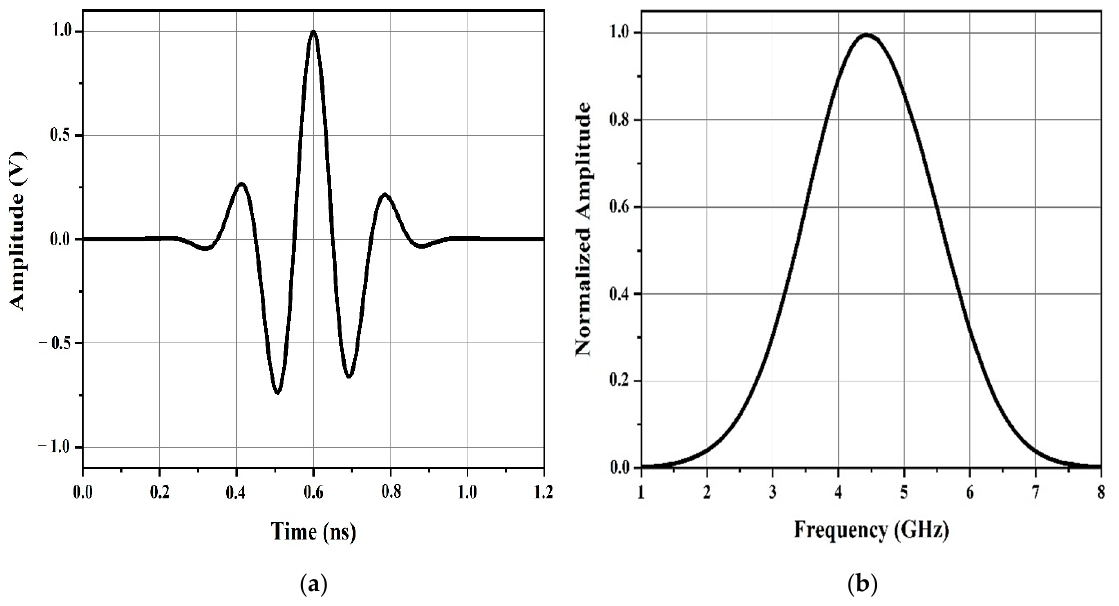
Figure 5. ( a ) Time domain of the ultra-wideband (UWB) interrogation pulse and ( b ) frequency spectrum of the interrogation pulse.